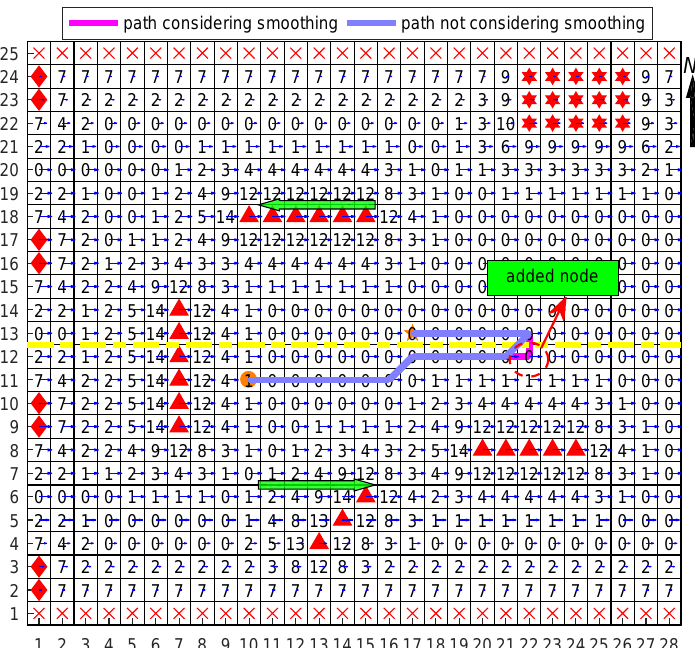
Figure 10. Combined path generated by an improved A-Star algorithm considering or not considering smoothing (The definition of the graphic symbols in this figure is the same as the definition in Figure